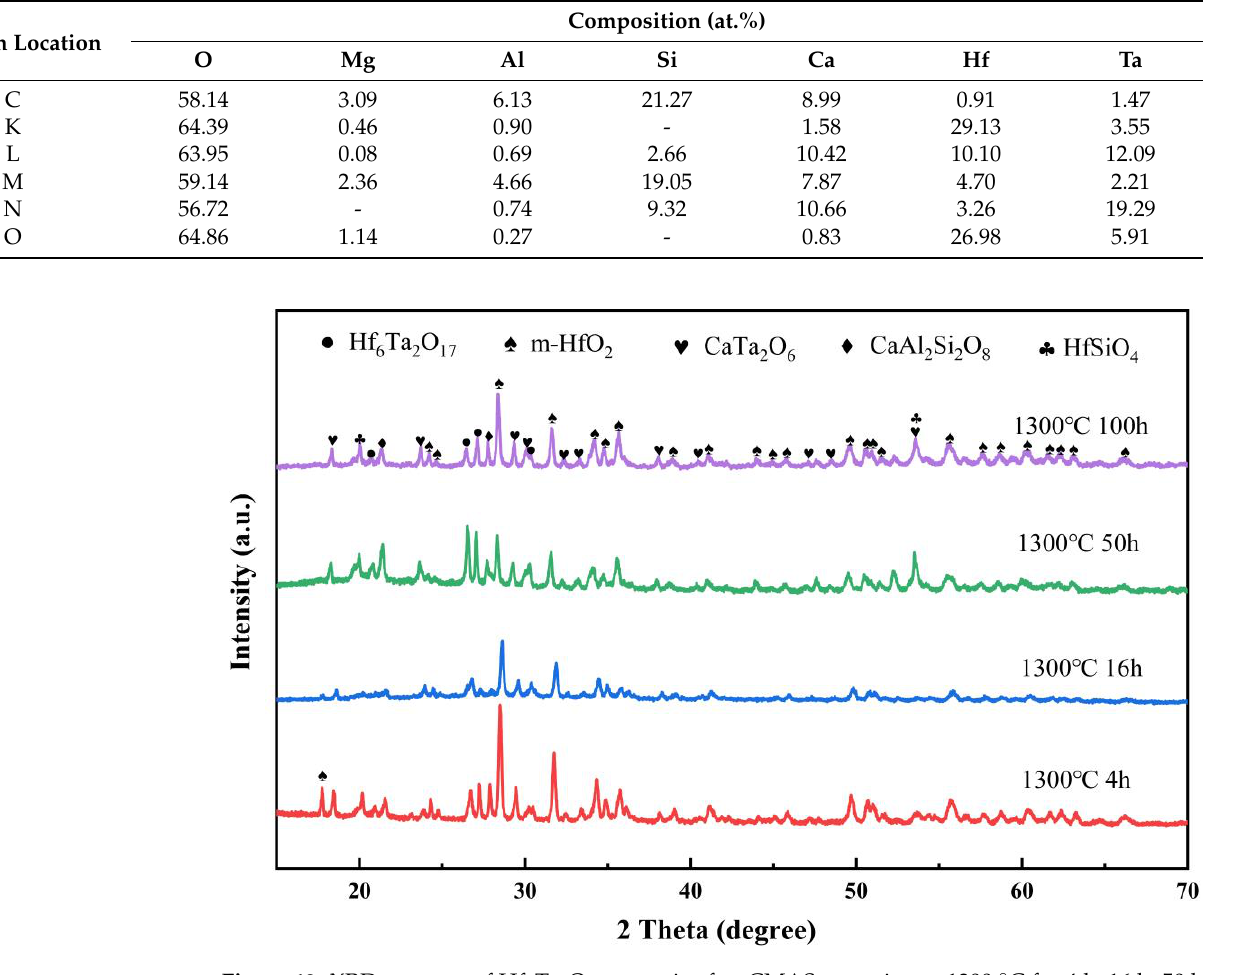
Figure 12. XRD patterns of Hf 6 Ta 2 O 17 ceramic after CMAS corrosion at 1300 °C for 4, 16, 50 and 100 h.